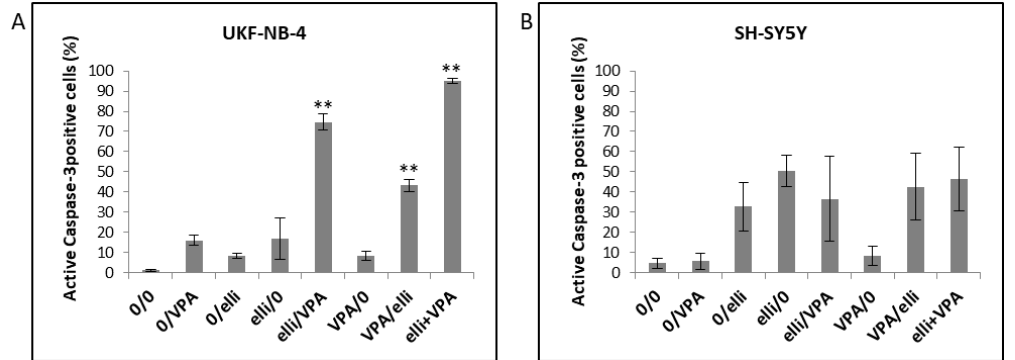
Figure 6. The percentage of UKF-NB-4 ( A ) and SH-SY5Y ( B ) cells with active caspase-3 after treatment with 1 mM valproic acid (VPA), 5 µM ellipticine (elli) and their combinations for 48 h. Experimental treatment conditions are shown in Table I. Values represent mean ± SD from three independent experiments. ** p < 0 .01 as compared to elli/0 group (ANOVA with post-hoc Tukey HSD Test).